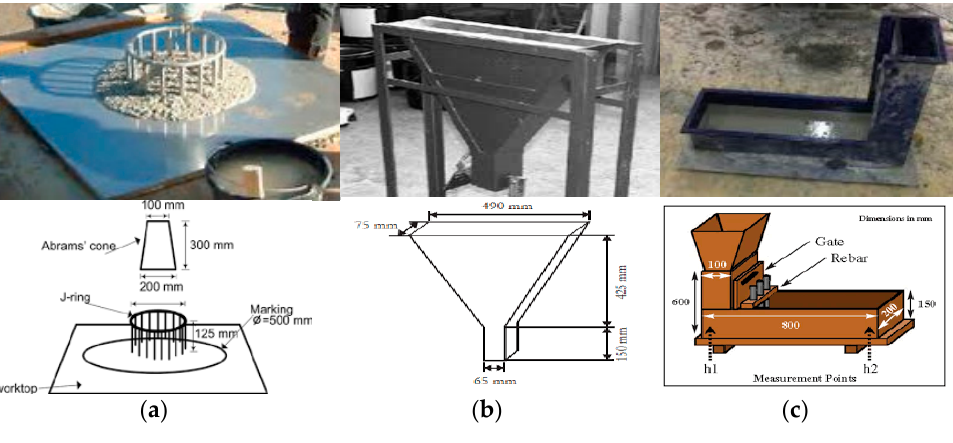
Figure 3. Standard ( a ) J-Ring, ( b ) V-Funnel ( c ) L-Box test